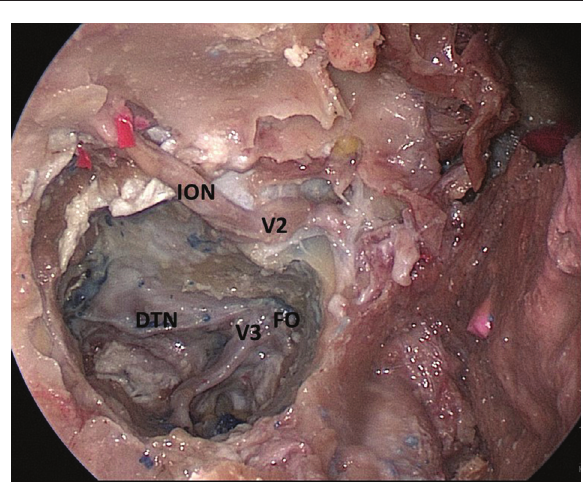
Dissection following the transpterygoid approach to the right infra- temporal